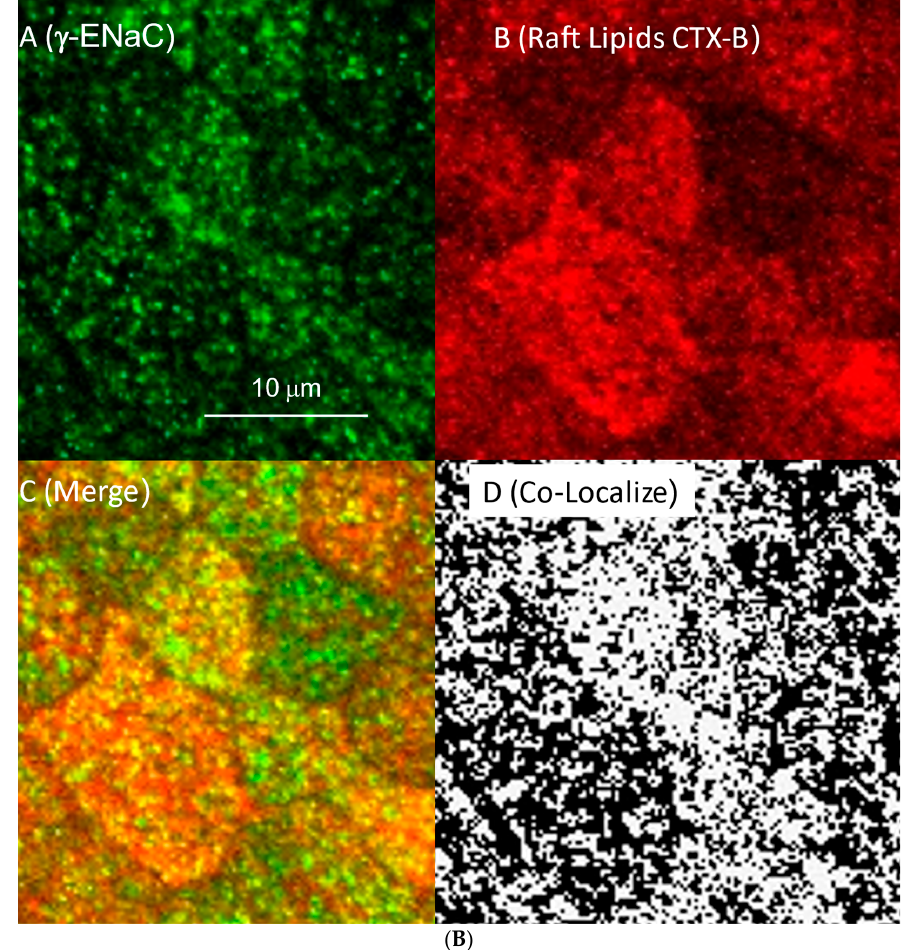
Figure 8. ( A ) γ -ENaC co-localizes with the lipid domain marker cholera toxin-B. The first image in the upper left shows the apical surface of mpkCCD cells labeled with an anti- γ ENaC antibody, while the upper right shows the CTX-B labeling corresponding to glycosphingolipids in lipid domains. The lower left shows the merged images with yellow-orange indicating co-localization. Panel D shows in white the locations in the upper panels where a red pixel and a green pixel of similar intensities overlap. The co-localization coefficient is 0.783. There are areas that are green with little red, but few areas of red that do not colocalize with green implying that specialized lipid domains have ENaC. We used the “colocalization finder” plugin of “Image J” (8) to analyze our images for colocalization of the labels for CTX-B and γ -ENaC antibodies, as we did in Figure 6. This plugin allows the user to identify pixels that contain both channel 1 ( γ -ENaC fluorescence–green) and channel 2 (CTX-B fluorescence–red). These pixels are then highlighted in white on separate images. We restricted the analysis to pixels having ratios of intensity values in the two channels greater than 0.1. ( B ) The images below are magnified images of the inset areas of the larger image to better visualize cells and colocalization.